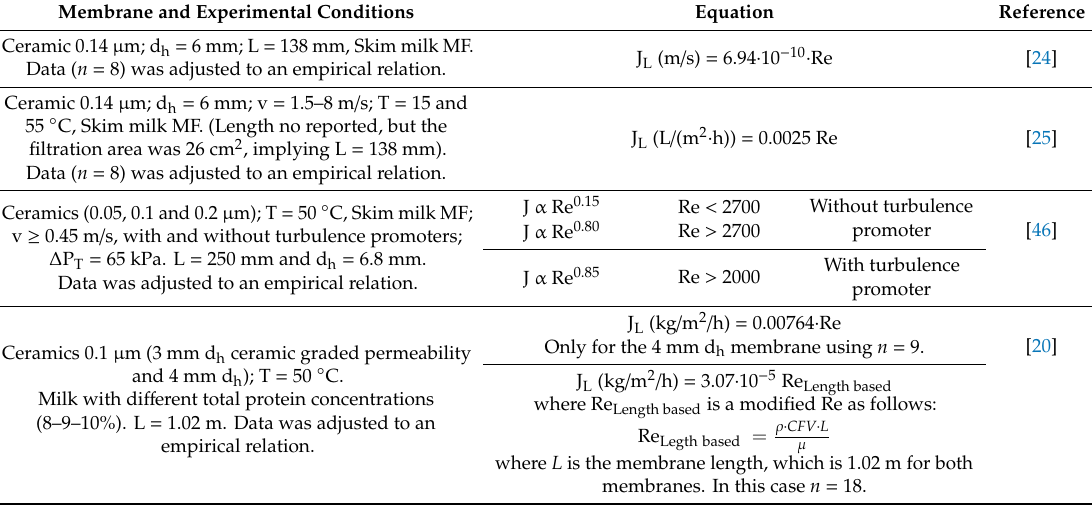
Table 4. Correlations between the limiting flux and the Reynolds number reported in the literature. Membrane and Experimental Conditions Equation